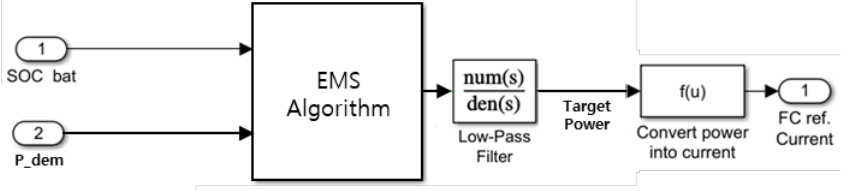
Figure 8. Implemented energy management strategy model in MATLAB/Simulink.